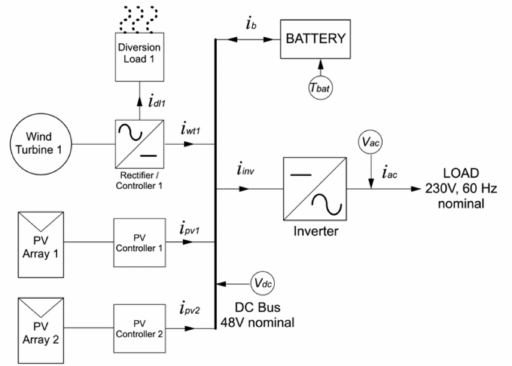
Figure 3. Scheme of Laguna Grande hybrid